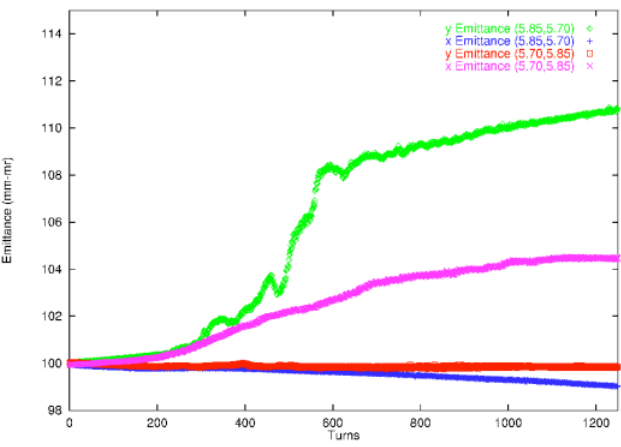
FIG. 11. (Color) Emittance growth tends to occur in the direction of the lesser